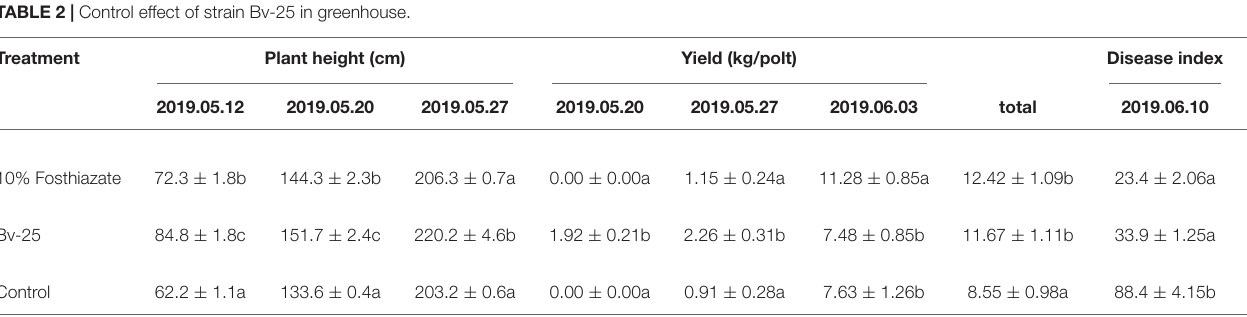
FIGURE 7 | Control efficiency of Bv-25 on M. incognita in the pot experiment. Cucumber seedlings were treated by Bv-25 fermentation broth, 1.8% avermectin, or sterile water. A total of 300 M. incognita J2s were inoculated to the cucumber roots. The number of galls was counted after 30 days. Different letters indicate significant differences ( p < 0.05; n = 30) between treatments according to Duncan multiple-range test following one-way ANOVA. TABLE 2 | Control effect of strain Bv-25 in